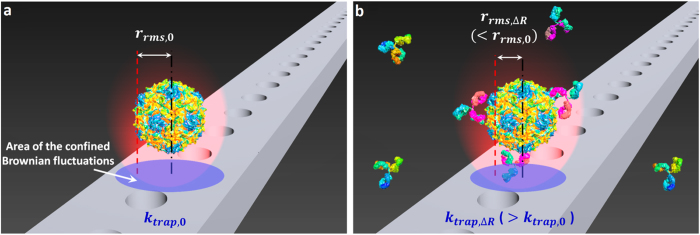
Detection principle for label-free detection of binding interactions between an influenza virus and antibodies.(i) A single influenza virus is captured in a nanophotonic near-field trap (ii) Detection of binding of an anti-influenza antibody to the virus within the optical trap. The analysis of the Brownian fluctuations determines the decreased rrms (or increased ktrap) resulting from the bindings. Note that subscript 0 denotes an initial measurement, and subscript ∆R denotes the measurement at equilibrium. Note that this illustration of the technique was constructed using models from the Protein Data Bank (PDB) Embedded Python Molecular Viewer (ePMV) open-source plugin, and the hemagglutinin envelope of the influenza virus used in this study was not illustrated for simplification.